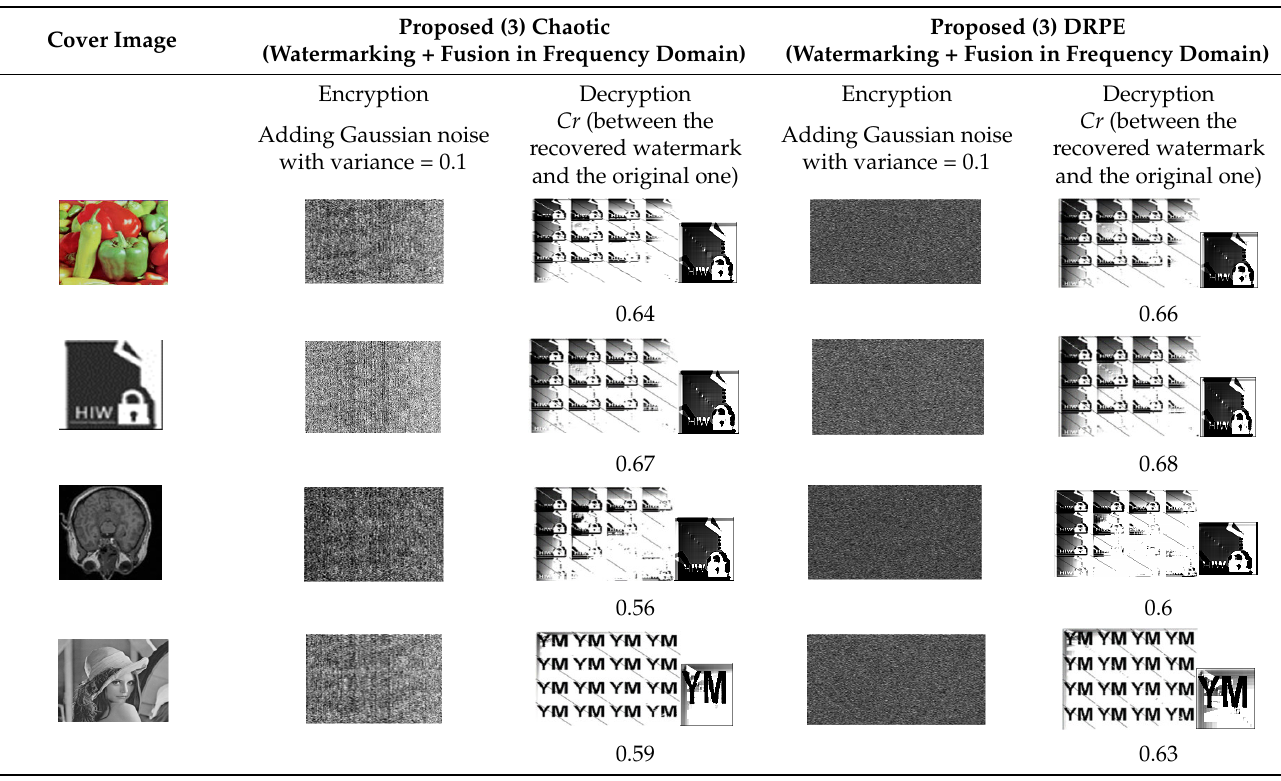
Table 14. Gaussian noise images and corresponding extracted watermarks for the third proposed technique.